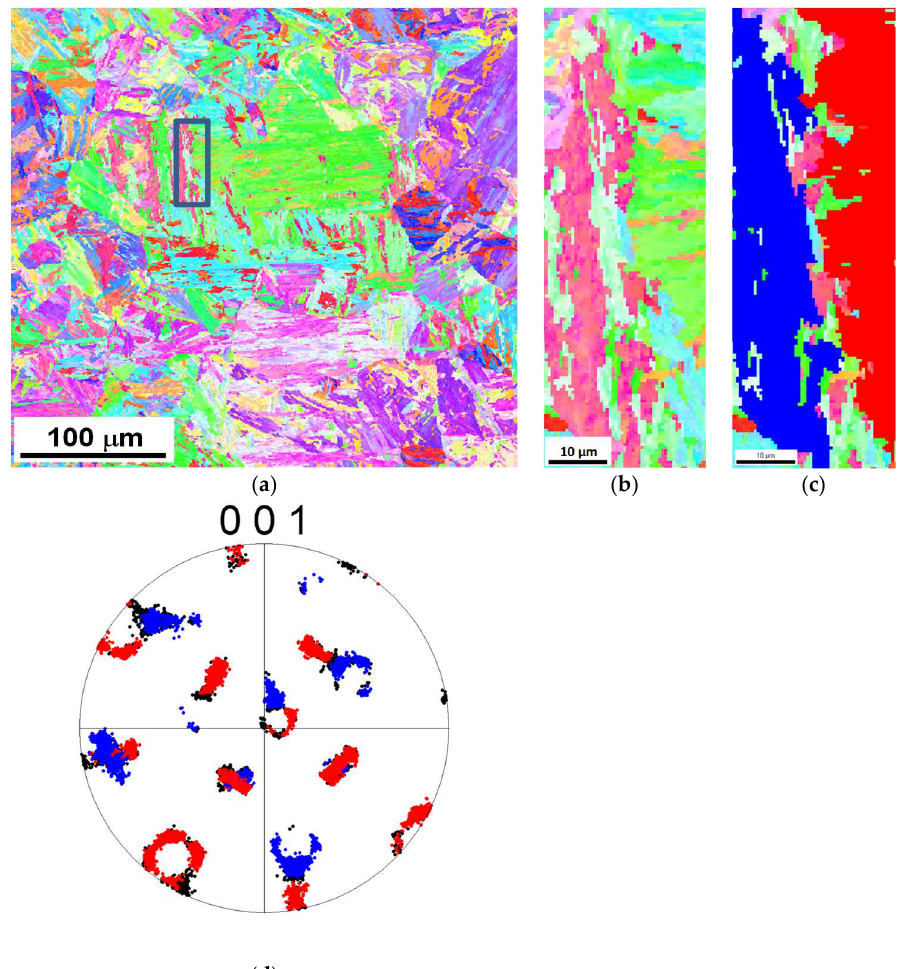
Figure 9 . ( a ) IPF (Inverse pole figure) ND orientation map from martensite marking the analysis area; ( b ) enlarged martensite IPF ND map of the analysis area; ( c ) martensite IPF ND map of the same area with red and blue colors superimposed to mark highlighted points in ( d ); ( d ) pole figure of the crystallographic data in ( b ) with points corresponding to areas in ( c ) highlighted using the same colors.